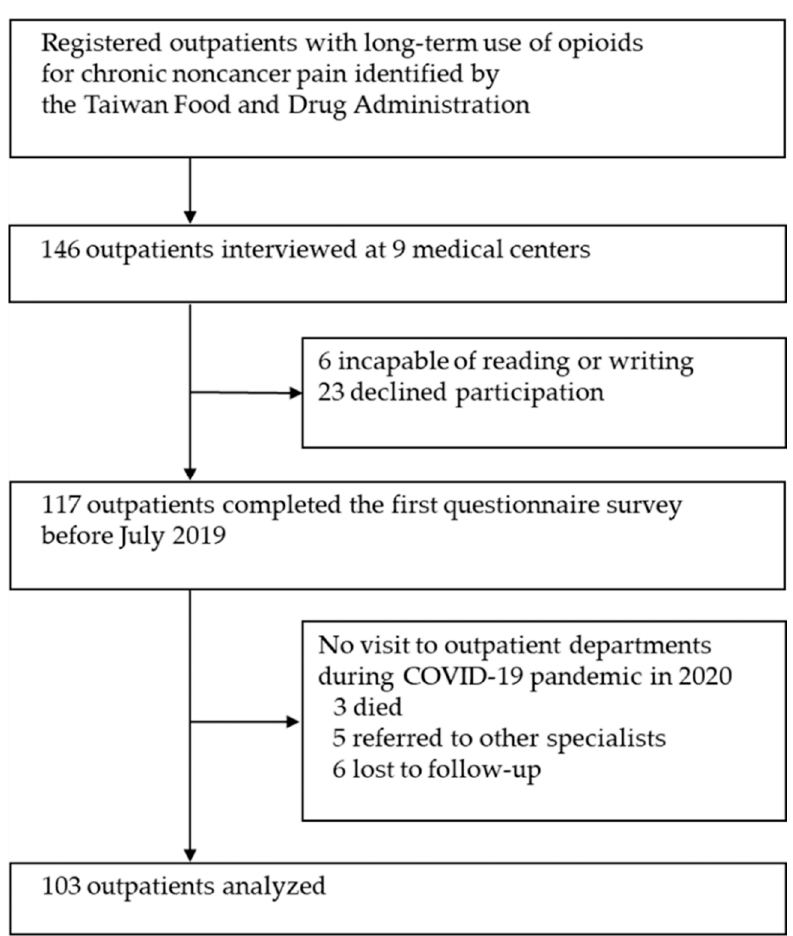
Figure 1. Participant enrollment